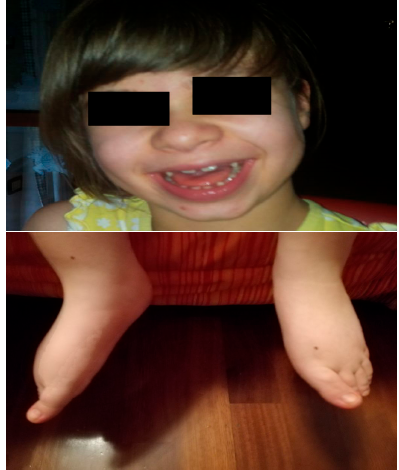
Figure 1. Dysmorphic features of the patient. Pedal edema, microcephaly, bulbous nasal tip, large mouth.